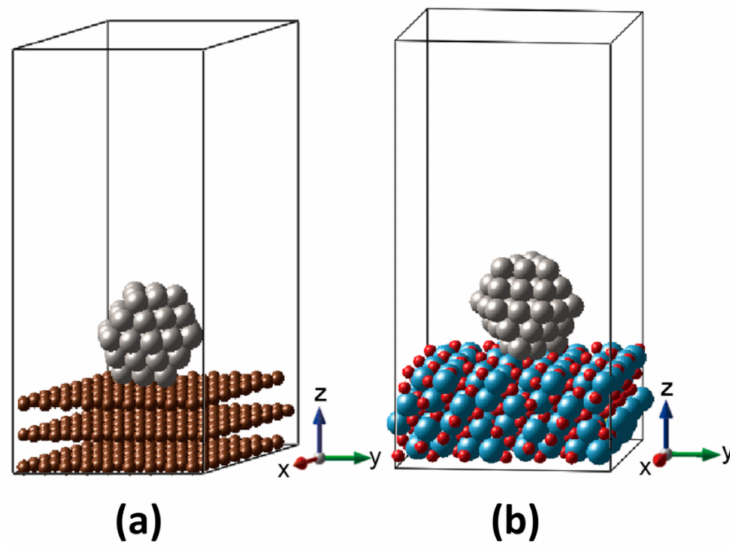
Figure 1. Designed models of ( a ) Pt/C and ( b )